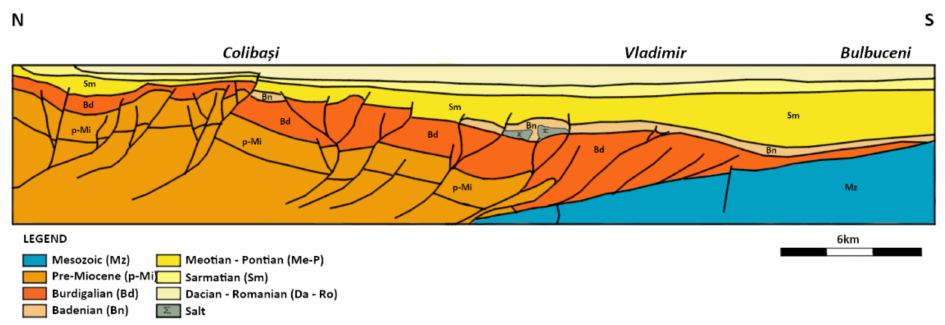
Figure 3. N–S Geological cross-section of the Getic Depression through Colibas structures. Modified from